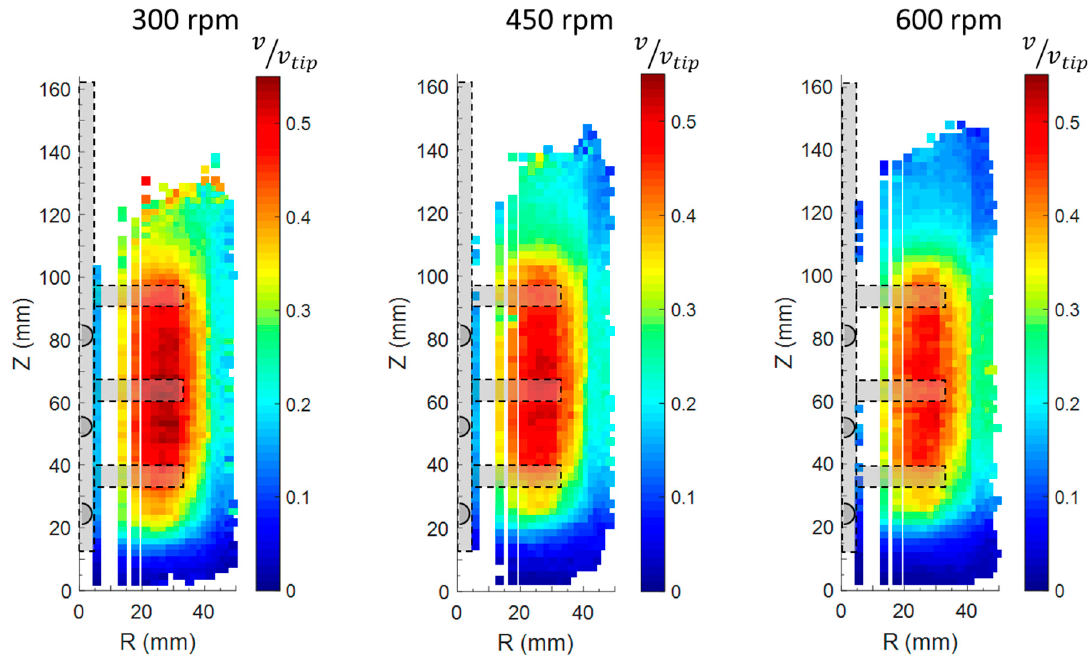
Figure 4. PEPT dimensionless velocity magnitude ( v/v tip ) at the different impeller speeds of 300 rpm, 450 rpm and 600 rpm. Test case using the bead loading of 2.4 kg and the bottom clearance of 12.7 mm.